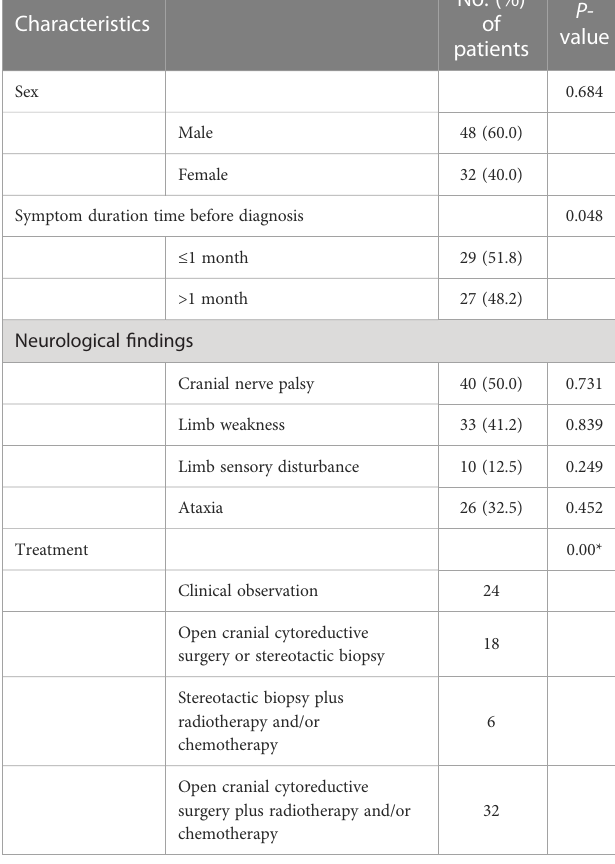
Characteristics